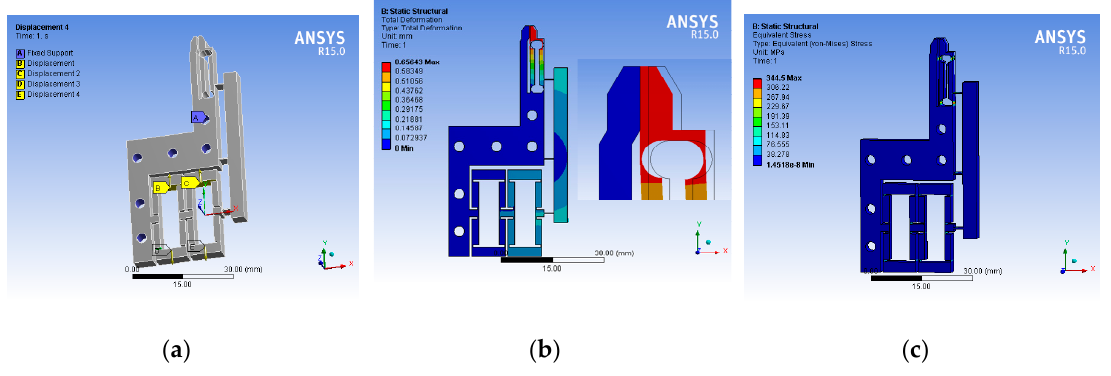
Figure 6. FEA diagram of the microgripper: ( a ) FEA settings, ( b ) deformation pattern and ( c ) stress pattern.